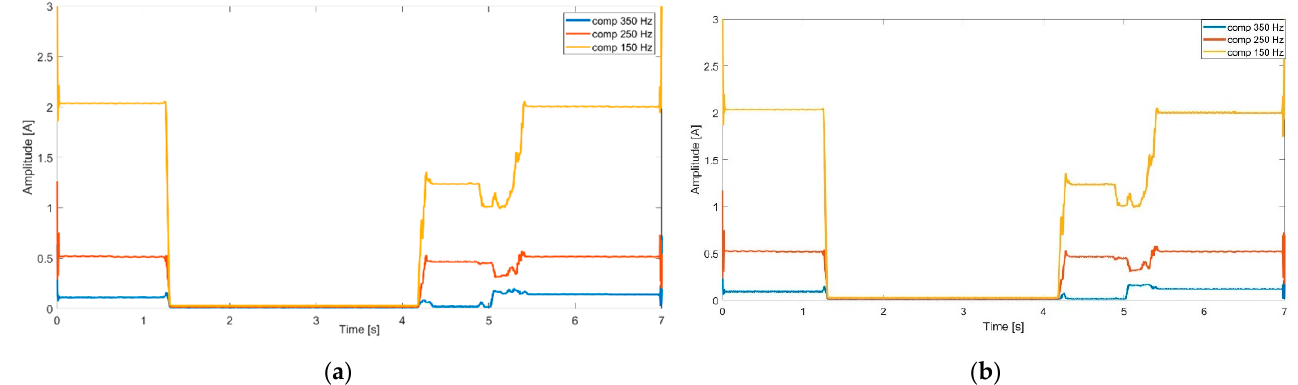
Figure 7. ( a ) Hilbert Spectrum results for the signal digitized at 50 kHz, ( b ) Hilbert Spectrum results for the signal digitized at 10 kHz.